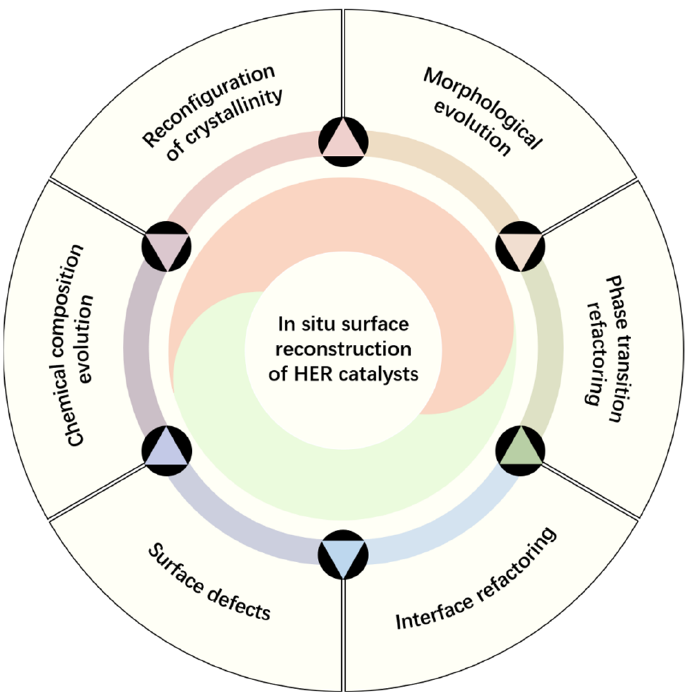
Figure 1. Schematic diagram of the in situ surface reconstruction of HER catalysts.